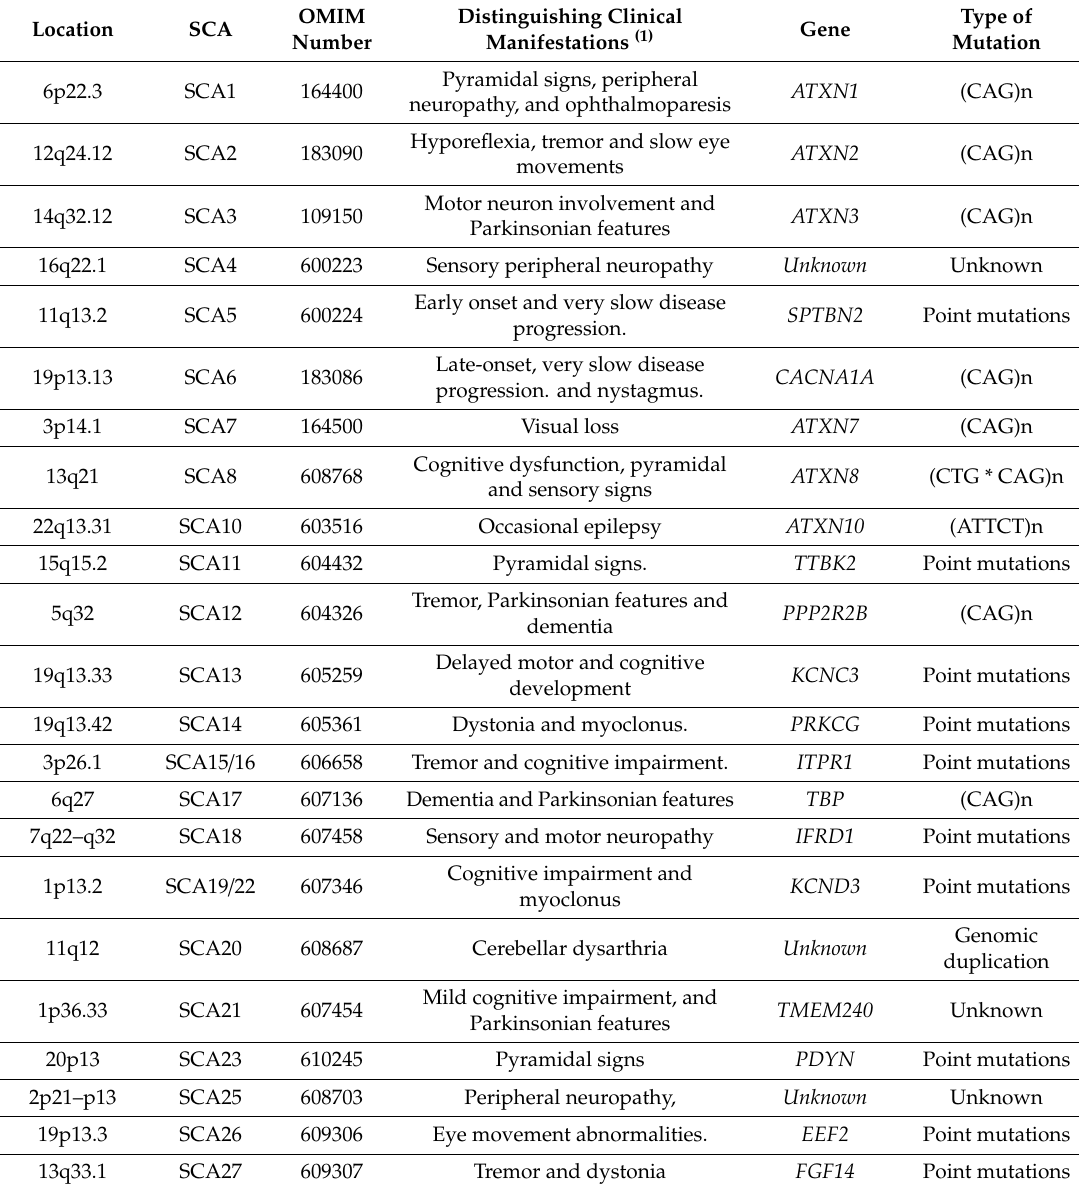
Table 1. SCA: Spinocerebellar